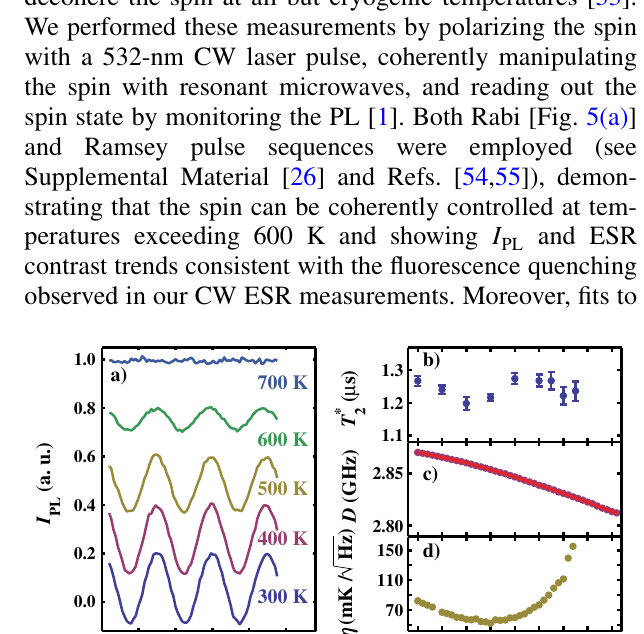
FIG. 4. Temperature-dependent ESR contrast [ C ð T Þ , red points] and I PL ð T Þ (blue points). Both quantities were normal- ized by their 300 K values ( (cid:3) 0 : 22 and (cid:3) 80 kCps , respectively). C ð T Þ was determined from fitting the CW ESR data and I PL was determined from Gaussian fits to confocal microscopy line scans. The solid lines represent predictions for C ð T Þ =C ð 300 K Þ and I PL ð T Þ =I PL ð 300 K Þ from a model of the CW ESR experi- ð T Þ and (cid:1) ð T Þ . ments depending on (cid:1) m m s ¼(cid:2) 1 s ¼ 0 decohere the spin at all but cryogenic temperatures [53].